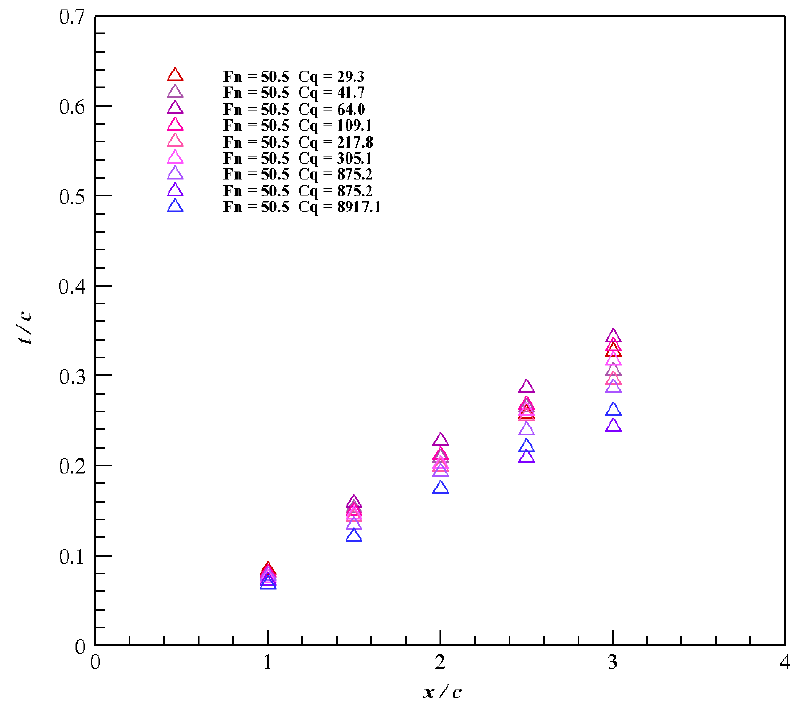
Figure 18. The non-dimensional jet thickness, t / c , variation along the non-dimensional stream-wise distance, x / c , for various non-dimensional air injection rates, C q , at Reynolds number, Re air = 50.5.